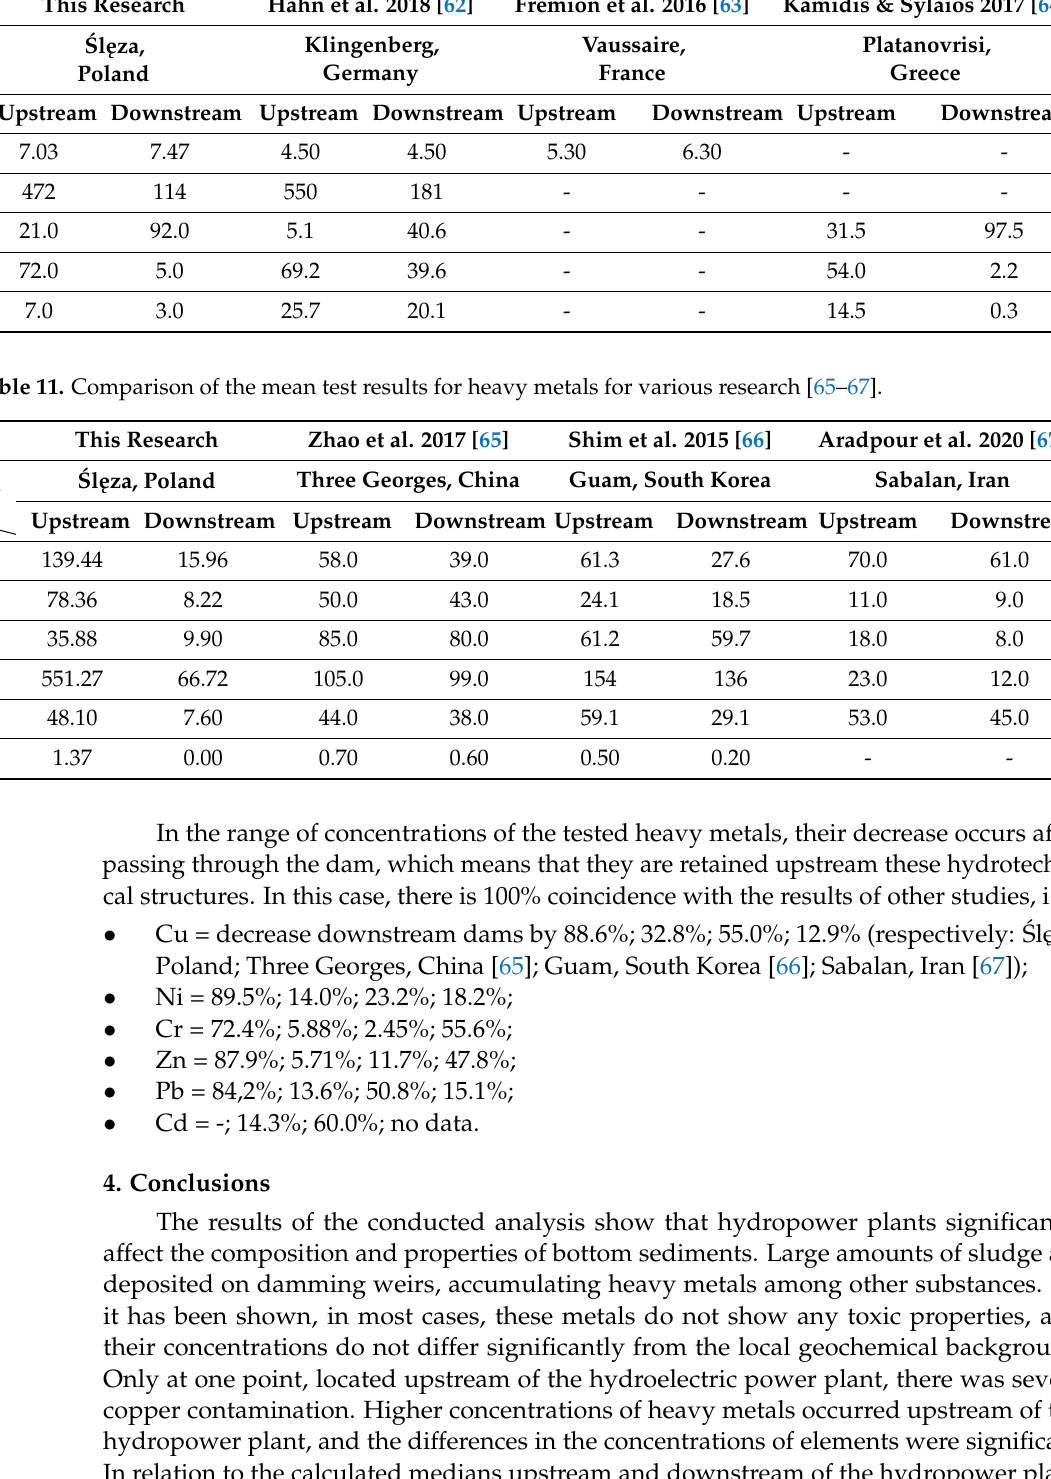
Table 10. Comparison of the mean test results for pH, EC and particle size distribution for various research [62–64]. Reference